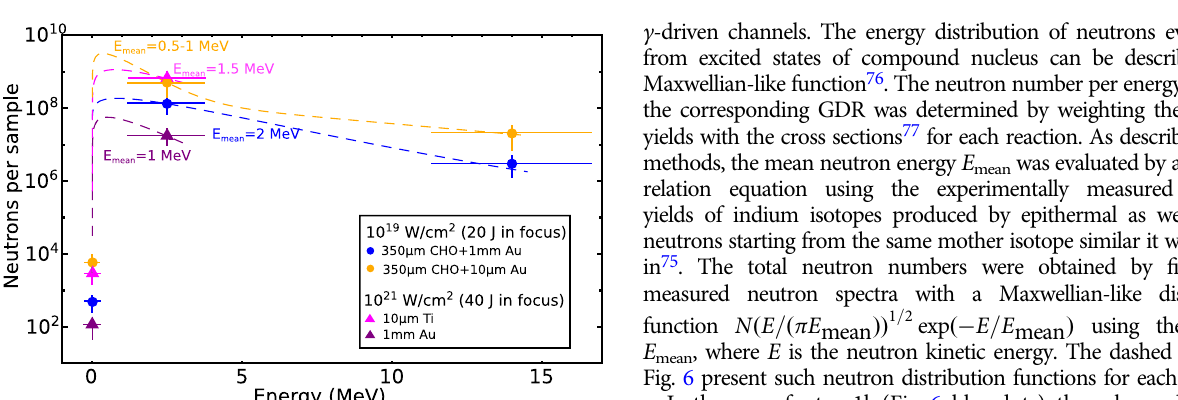
Fig. 5 Protons. a Proton number in arbitrary units as a function of proton energy. Yellow dots are proton number evaluated in case of laser interaction with aerogel-foams combined with thin metal foils at 10 19 W/cm 2 intensity (setup 1a), while the magenta dots describe proton number obtained in laser interactions with thin metal foils at 10 21 W/cm 2 laser intensity (setup 2a). Error bars represent the accuracy of reaction yield and the width of nuclear resonance used for spectral reconstruction. The dashed curves demonstrate the different slopes of proton spectra. PIC-simulated proton spectrum is shown as blue solid line. b IP signal produced by electrons above 7.5 MeV directed along the laser axis (FWHM range, black dashed circle) with positions of activation samples for detection of (p,xn)-reactions and expected direction of TNSA-accelerated proton beam (foil-target normal was + 10 ∘ to laser direction). The half protons divergence angle of 6 ∘ – 7 ∘ was estimated assuming a Gaussian angular distribution at the target normal and taking into account proton-induced reaction yields measured at 5 ∘ and 15 ∘ (black dotted circle). c Momentum diagram of protons from 3D PIC simulation (VLPL code). Transversal and longitudinal momenta are shown as normalized values, where the colors display the proton energies. Dashed lines indicate the half divergence angle ranges at 5 ∘ and 10 ∘ .